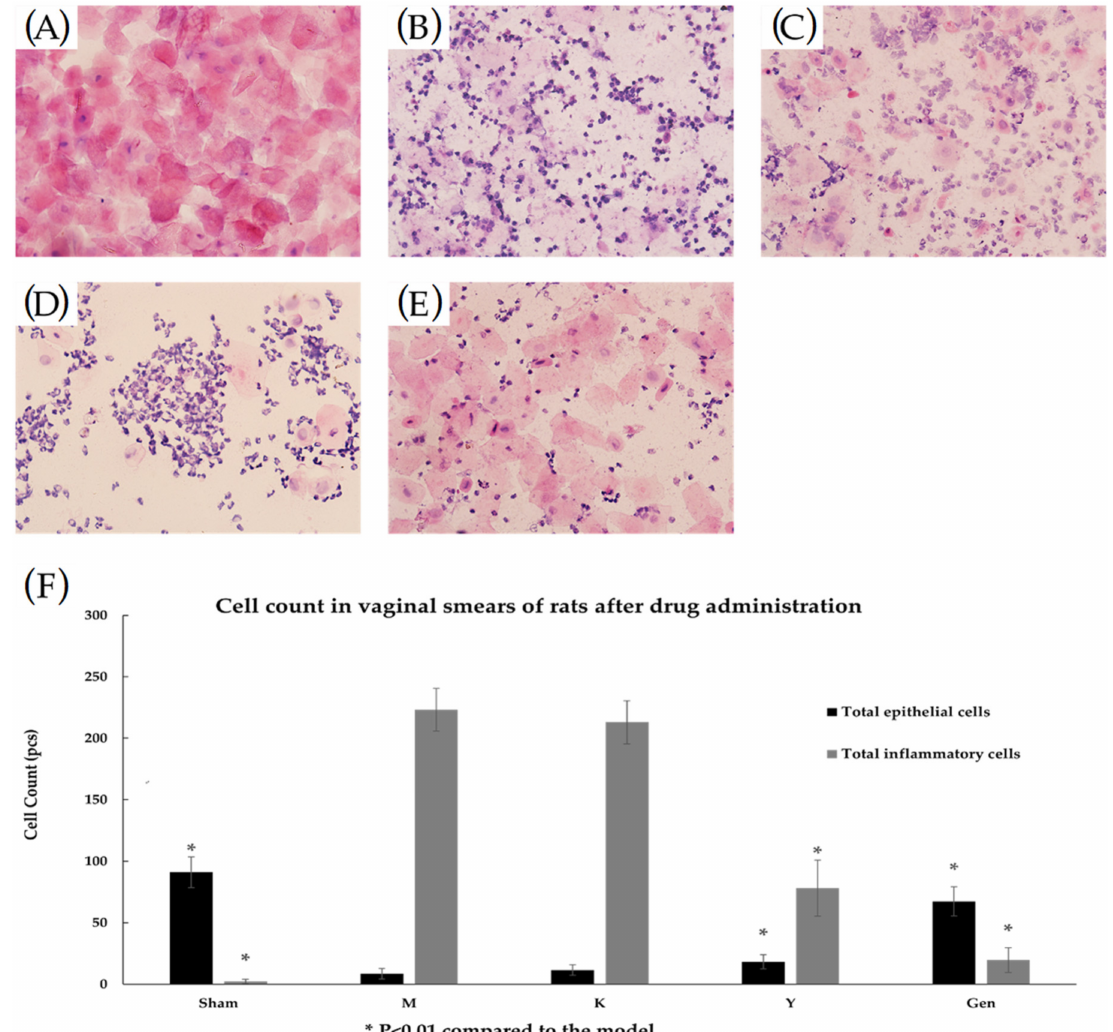
Figure 4. ( A ) After HE staining treatment, a vaginal smear from the Sham group of rats after administration of the drug showed a large number of epithelial cells and a very small number of inflammatory cells, (40X). ( B ) After HE staining treatment, vaginal smears from rats in group M after dosing were heavily infiltrated with inflammatory cells and a few epithelial cells, (40X). ( C ) Vaginal smears from rats in group K after treatment with HE stain, (40X). ( D ) After HE staining treatment, vaginal smears from rats in group Y before dosing were heavily infiltrated with inflammatory cells and a few epithelial cells, (40X). ( E ) After HE staining treatment, vaginal smears from rats in group Gen before dosing were heavily infiltrated with inflammatory cells and a few epithelial cells, (40X). ( F ) Results of separate counts of epithelial cells and inflammatory cells in vaginal smears of rats after dosing. For the Y and Gen groups compared to the M group, the number of epithelial cells increased significantly and the number of inflammatory cells decreased significantly, with the Gen group having a more significant effect. * p < 0.01 compared to the model